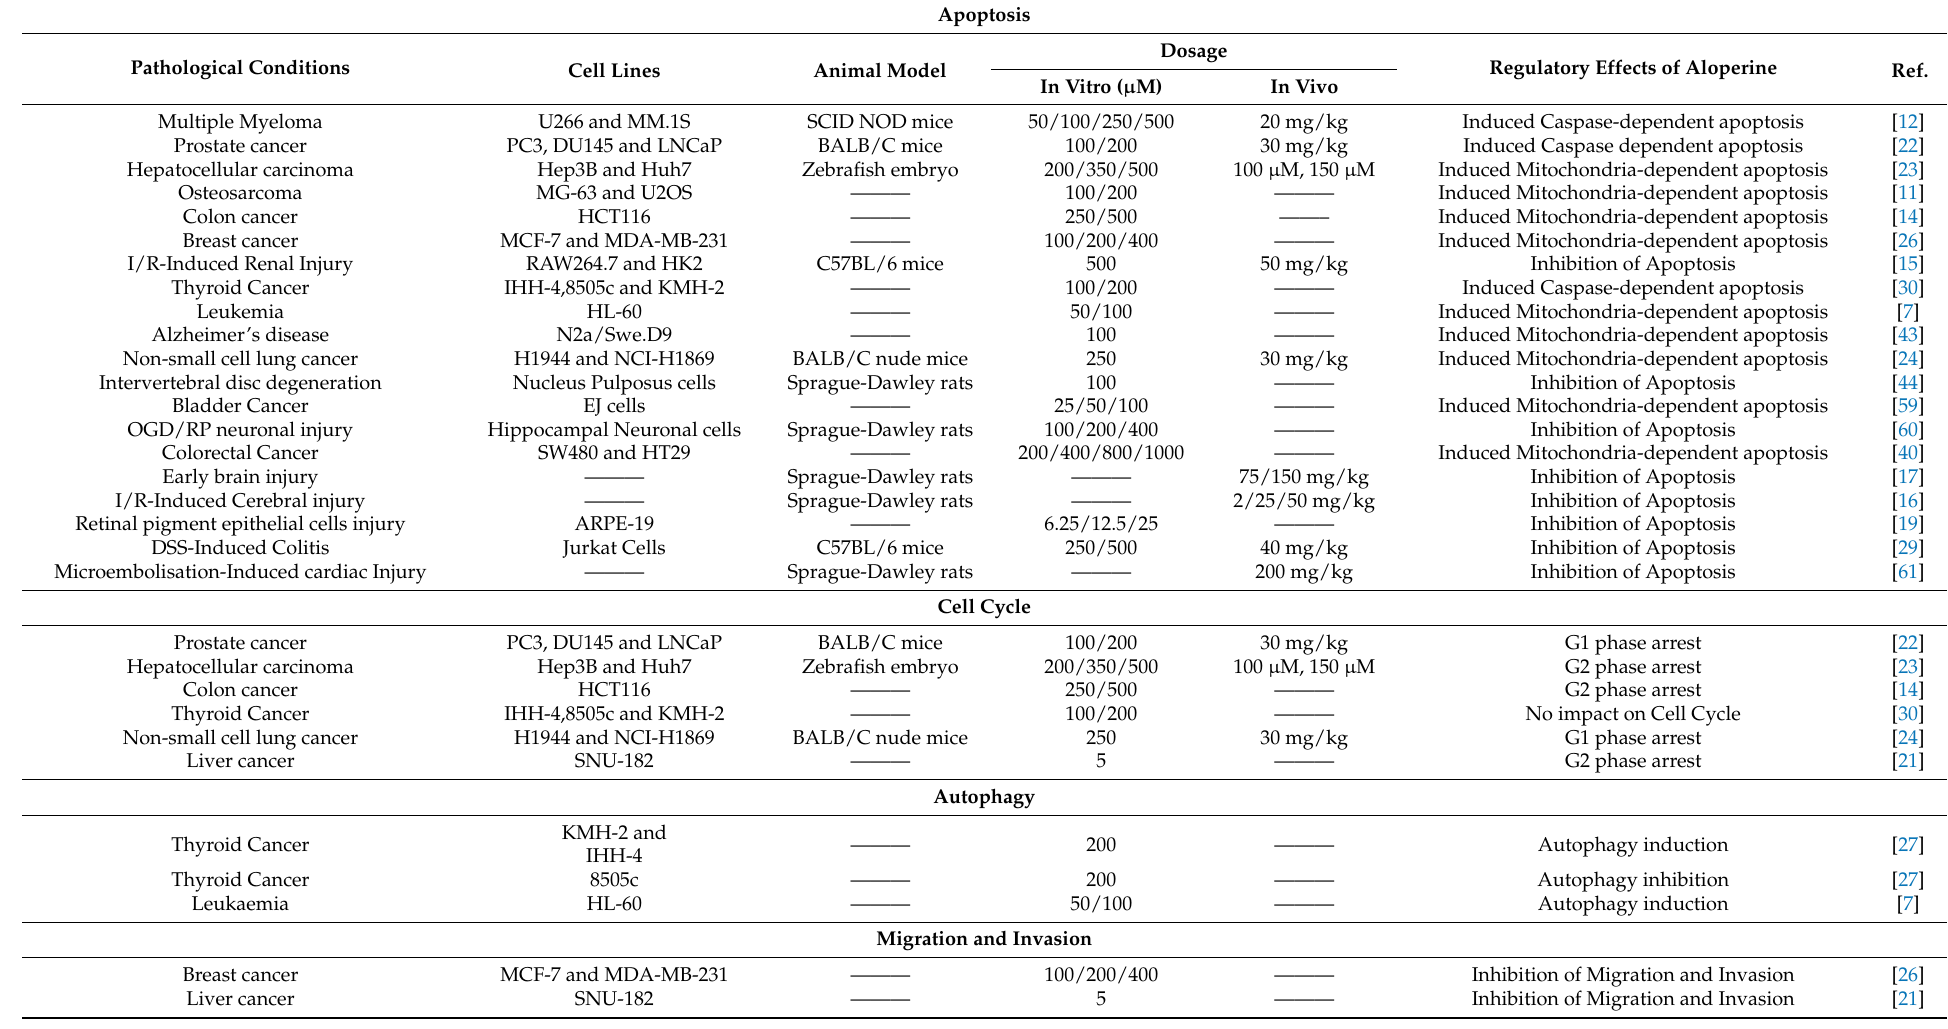
Table 1. Aloperine mediated modulations in biological